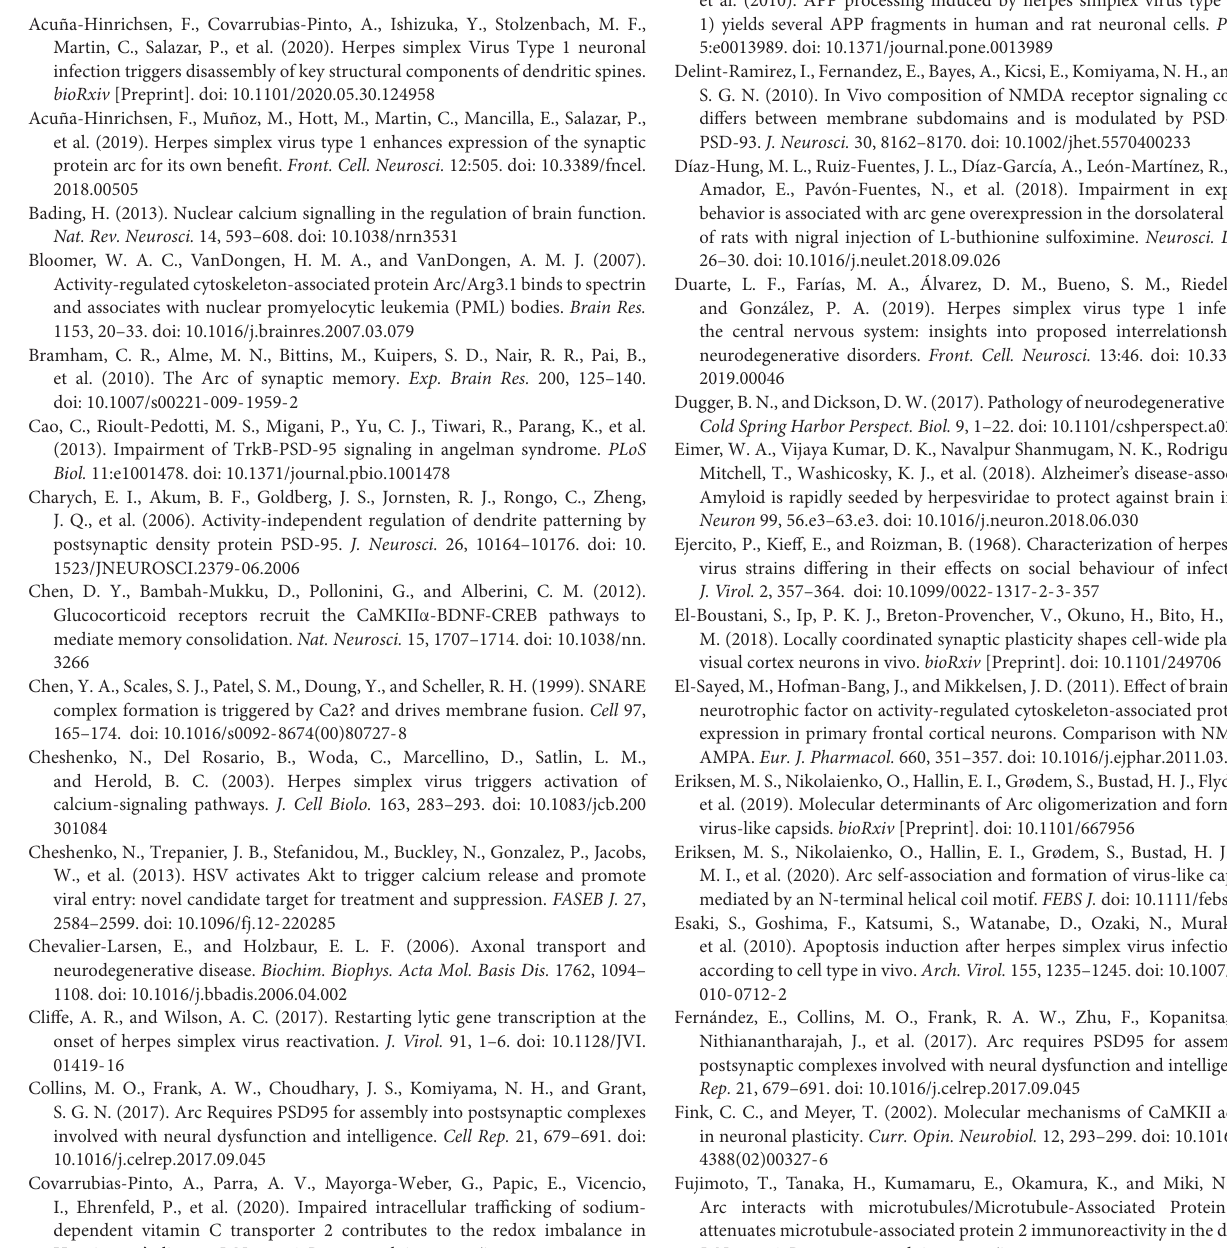
Supplementary Figure 2 | HSV-1 infection induces CREB phosphorylation and nuclear translocation in hippocampal cell lines. An HT22 mouse hippocampal cell line was infected with HSV-1 MOI 10, at 1, 4, 6, 8, and 18 h. (A) Immunoblot